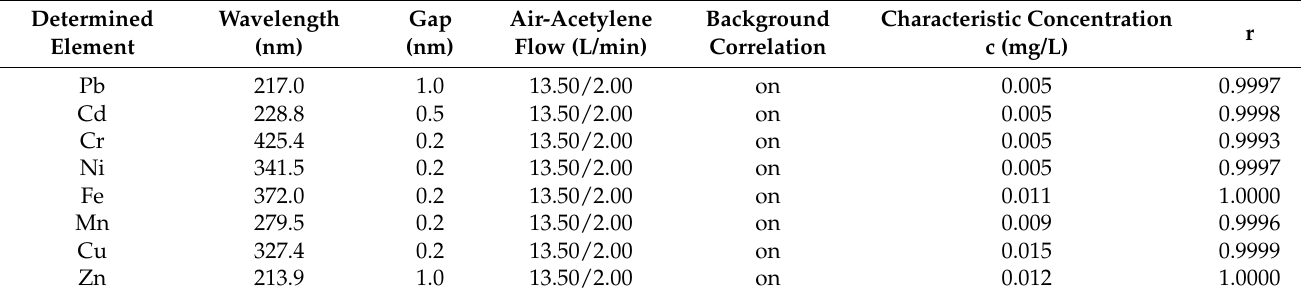
Table 1. Measurement